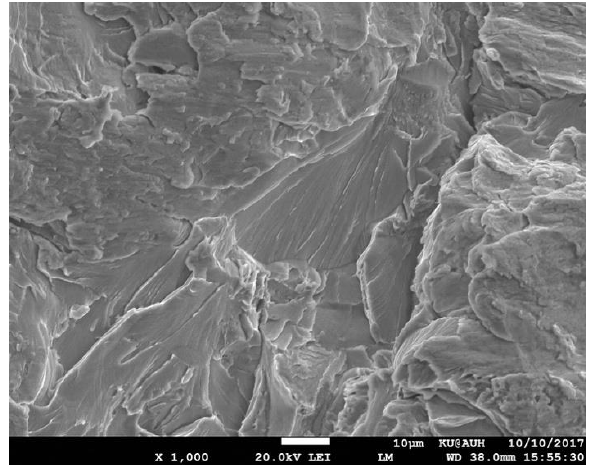
Figure 13. Cleavage fracture at SOHIC region.